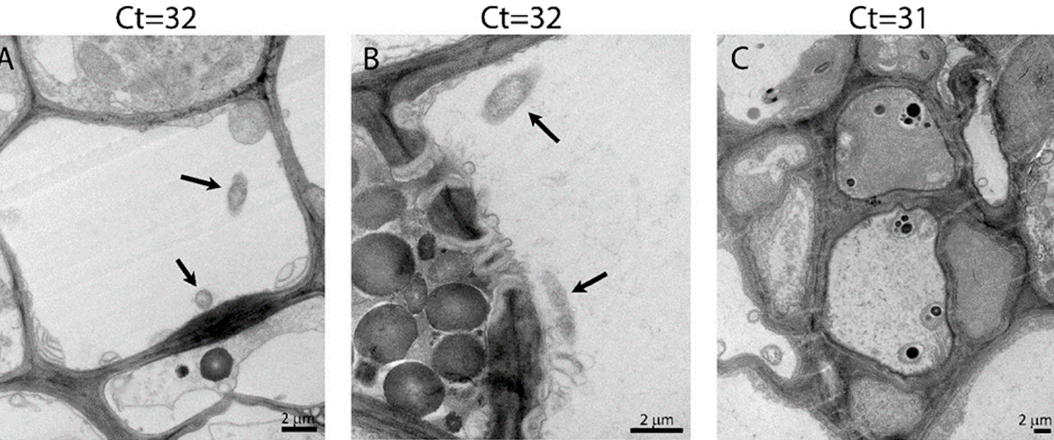
Figure 3. CLas cells in Cmac phloem. CLas bacterial cells were found in midrib sieve elements of a Figure 3. Changes in yields and canopy density and volume after CRF treatment. After three years plant with Ct values of 32 ( A , B ), but no cells were found in midrib of plant with Ct value of 31 ( C ). of CRF treatment, trees had higher yields ( A ). Loss of canopy density (measured as leaf area index) CLas cells are marked by an was smaller in CRF treated trees than in controls ( B ). There was no difference in canopy volume ( C ). Table 3. Comparison between Candidatus Liberibacter asiaticus quantification by qPCR and TEM. Variety